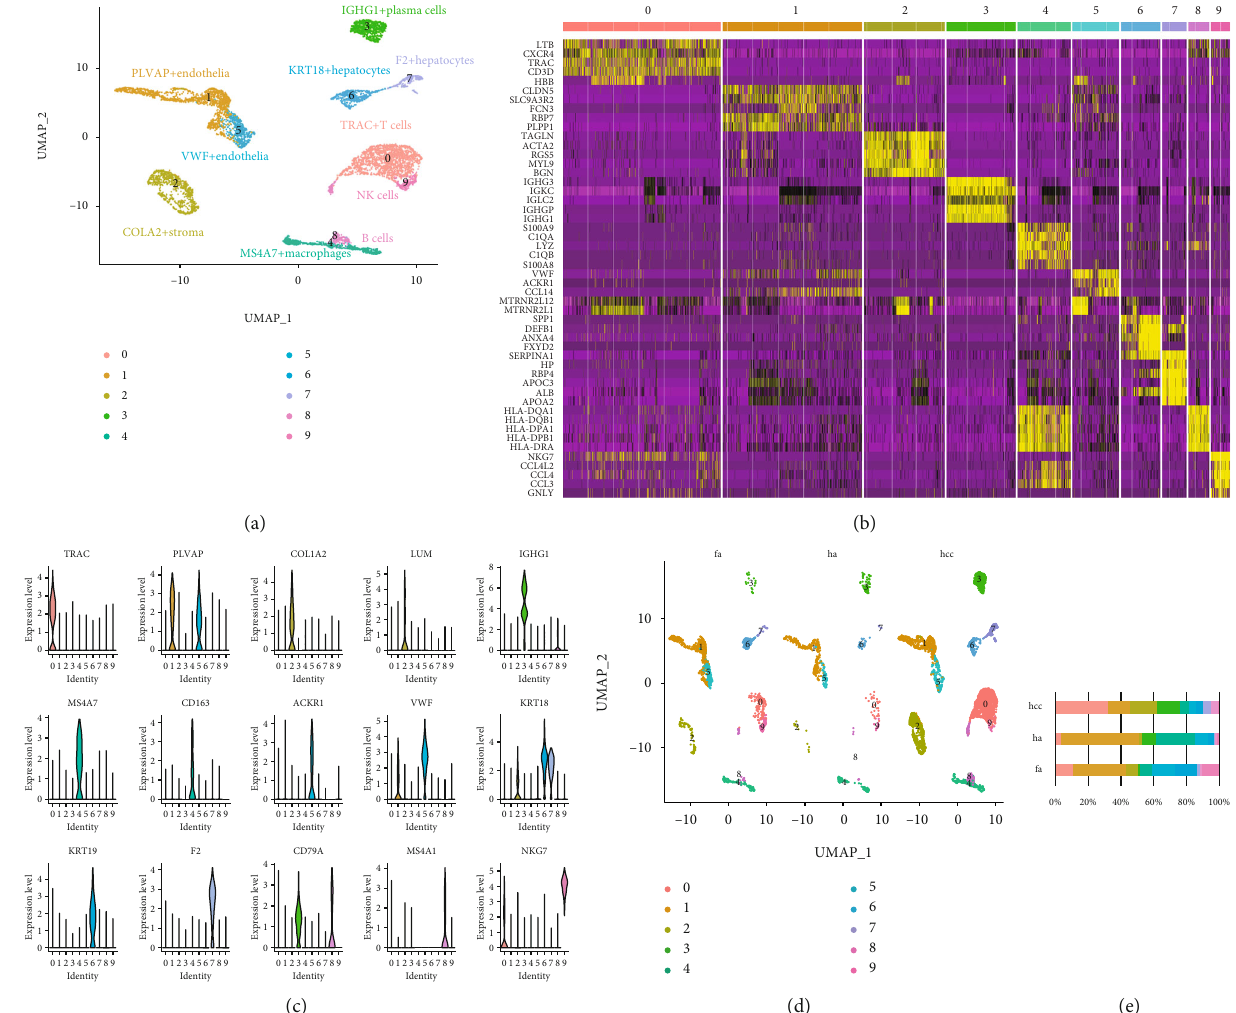
Figure 1: Single-cell RNA-seq analysis in the liver sample from healthy, fi brosis, and HCC patient. (a) UMAP diagram describes the 10 main cell types in the integrated liver biopsy samples. (b) Heat map annotated the di ff erent genes of the 10 main cell types. (c) Violin plots show the expression and distribution of marker genes. (d) Single-cell data of healthy (ha), fi brosis (fa), and HCC (hcc) patients. (e) Bar graphs quantify and compare the proportion of single-cell data of healthy (ha), fi brosis (fa), and HCC (hcc) (Figure 3(d)). Analysis of di ff erential gene expression for each subgroup (except c2) revealed the unique transcrip- tional con fi guration potential of epithelial cells derived from liver fi brosis and hepatocellular carcinoma (Figure 3(e)).